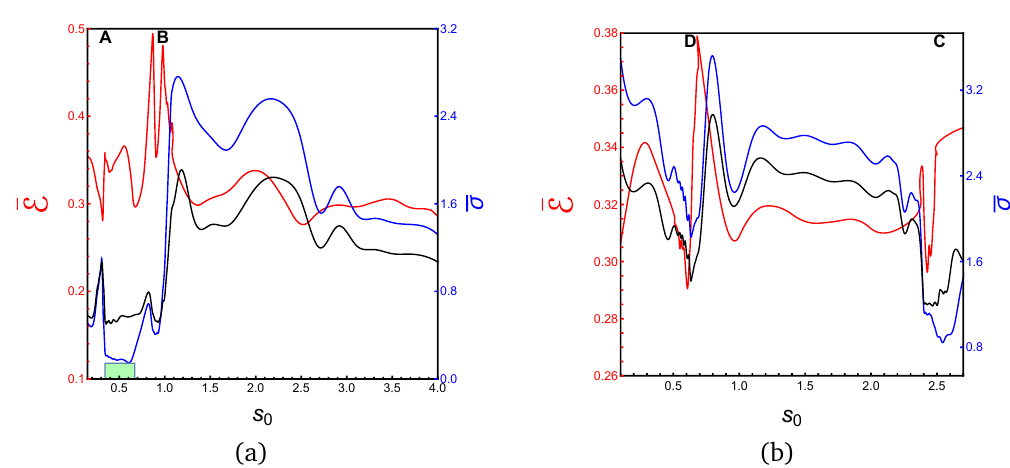
Figure 4: (a) Variation of ¯ E and ¯ σ with s 0 for s cut = 375 for upper boundary. (b) Variation of ¯ E and ¯ σ with s 0 for the lower boundary for s cut = 375. Blue line is for ¯ σ π 0 π 0 , black for ¯ σ π + π − and red for ¯ E . The green bar indicates linear Regge trajectory with R 2 >